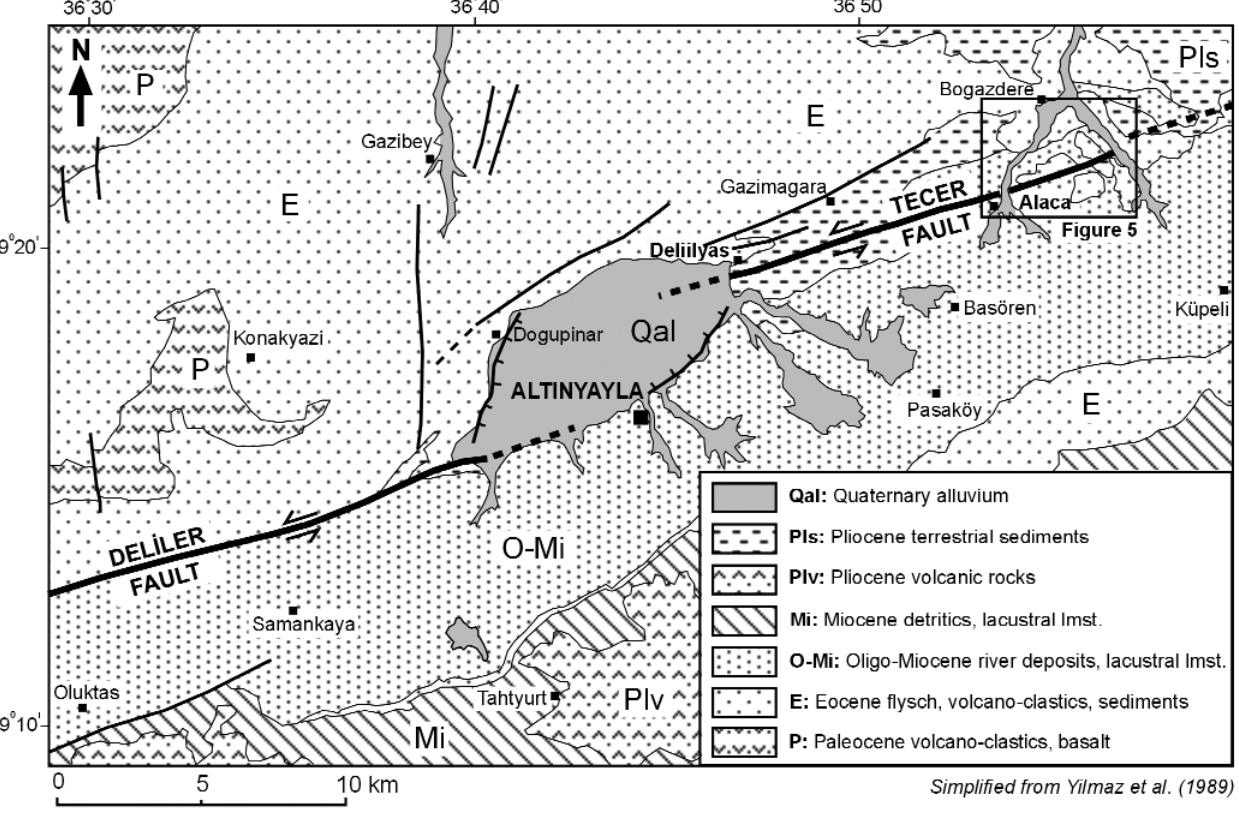
Figure 2. Simplified geological map of the Altinyayla area [modified from Yilmaz et al.